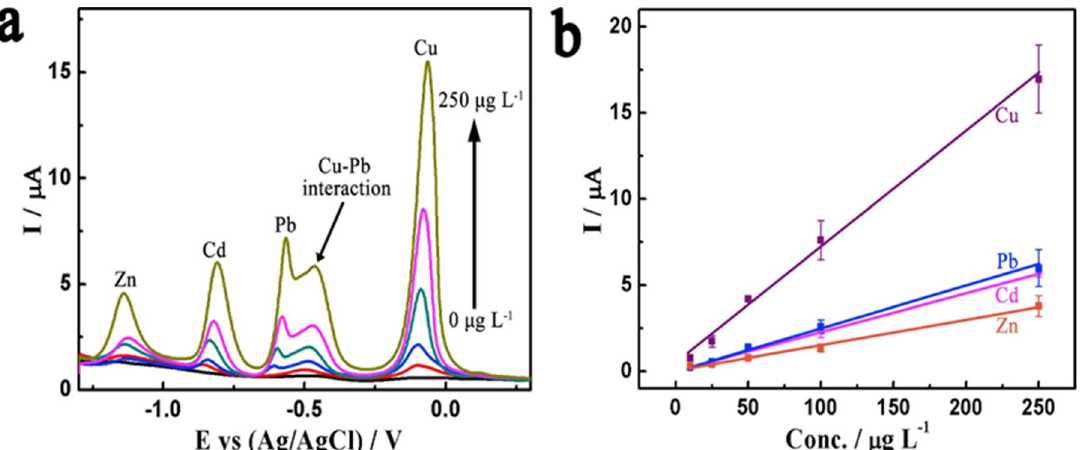
Figure 11. ( a ) Differential pulse anodic stripping voltammetry and ( b ) corresponding calibration plots for simultaneous analysis of Zn 2+ , Cd 2+ , Pb 2+ , and Cu 2+ obtained on a D/G nanoplatelets film electrode. Error bar: n = 3 (reproduced with the permission of [103]).